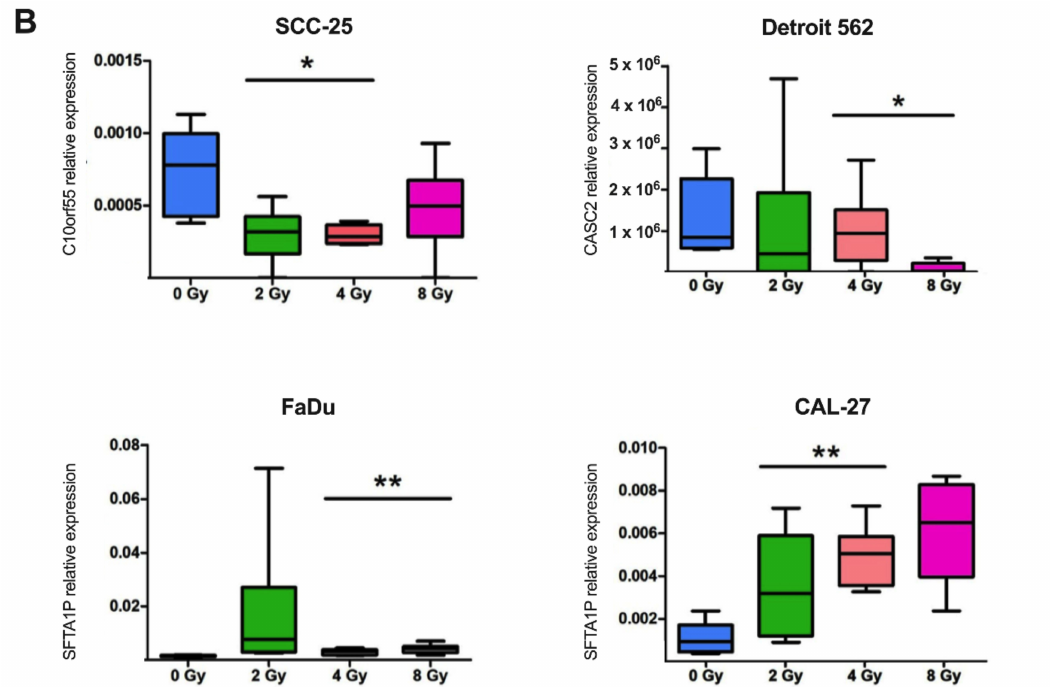
Figure 6. Relative expression of C10orf55, C3orf35, C5orf38, CASC2, MEG3, MYCNOS, SFTA1P, SNHG3, and TMEM105 lncRNAs after irradiation of HNSCC cell lines using doses of 0 Gy, 2 Gy, 4 Gy, and 8 Gy: ( A ) heat maps representing expression of specified lncRNAs and ( B ) expression of C10orf55, CASC2, and SFTA1P in selected cell lines; p < 0.05 considered significant, * p < 0.05; ** p <